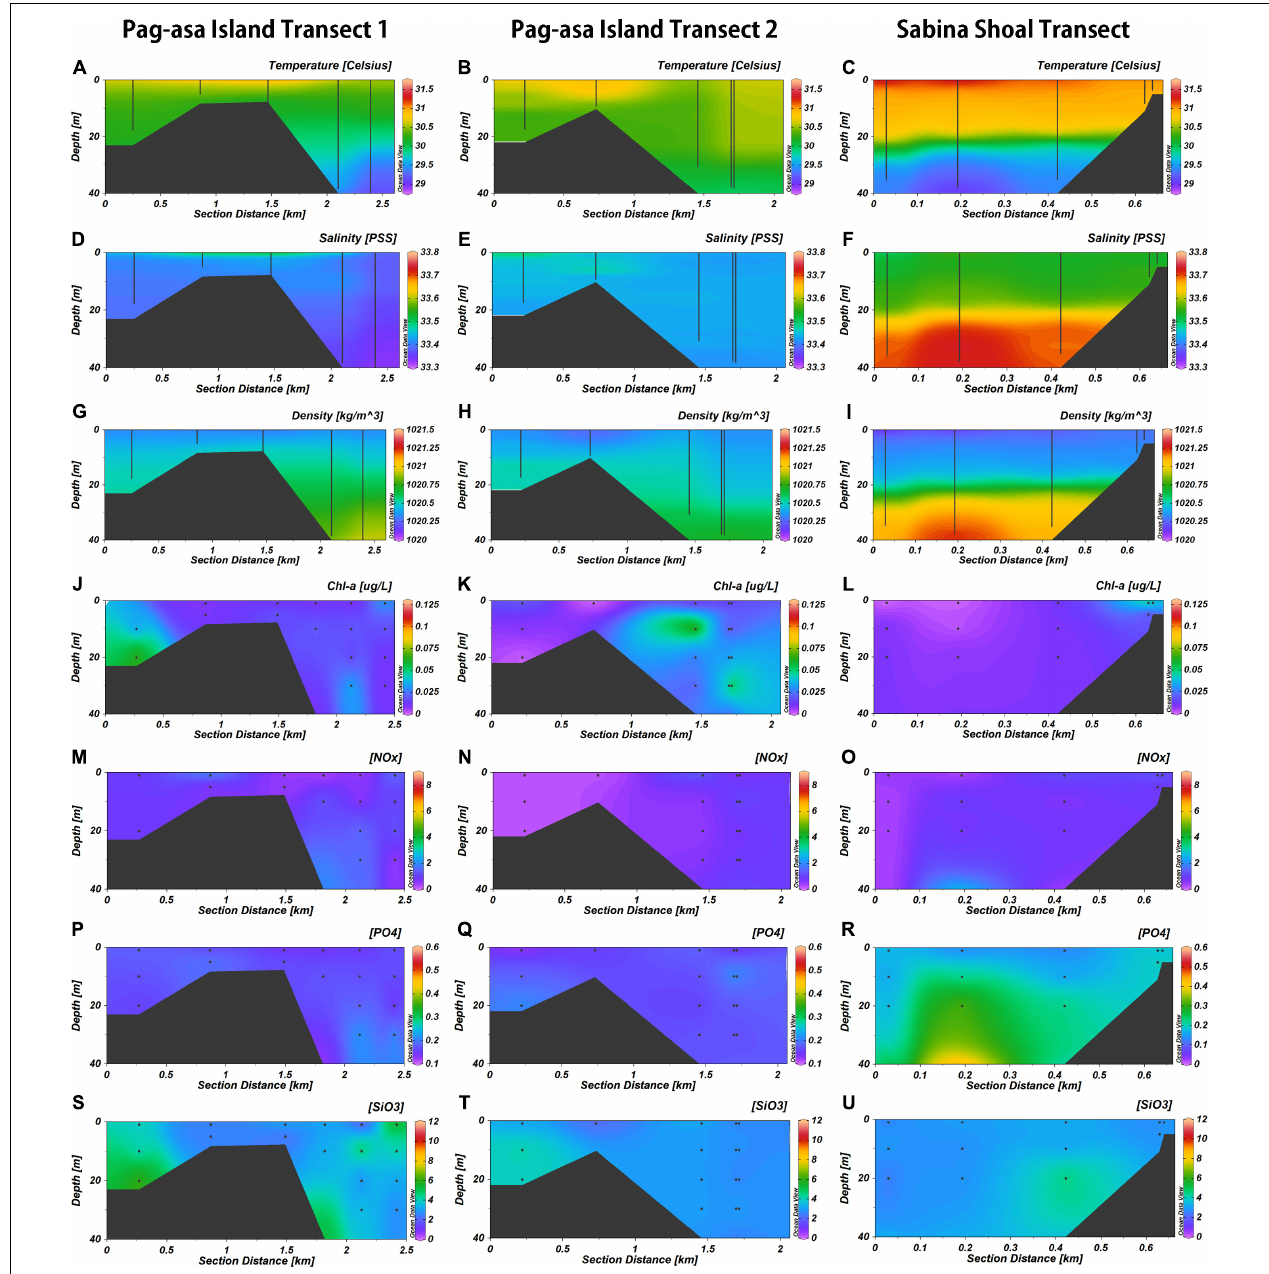
FIGURE 2 | Section plots of the three transects Pag-asa Transect 1 (A,D,G,J,M,P,S) , Pag-asa Transect 2 (B,E,H,K,N,Q,T) , and Sabina Transect (C,F,I,L,O,R,U) with contour plots for temperature, salinity, density, chlorophyll a (chl a ), phosphate (PO 4 ), nitrate and nitrite (NOx), and silicate (SiO3) for each